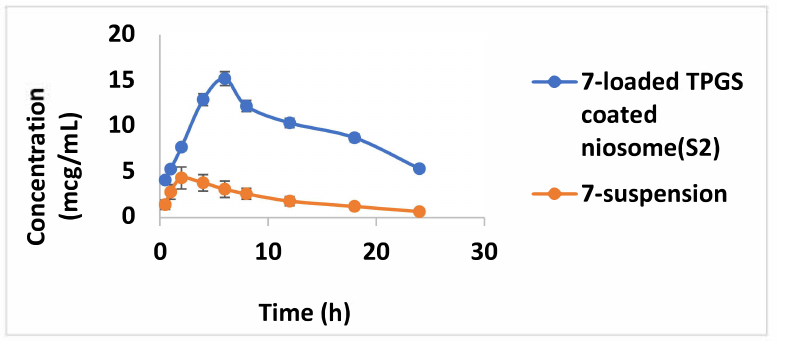
Figure 24. Plasma concentration-time profile of optimized 7 -loaded TPGS-coated niosome formula (S2) relative to the 7